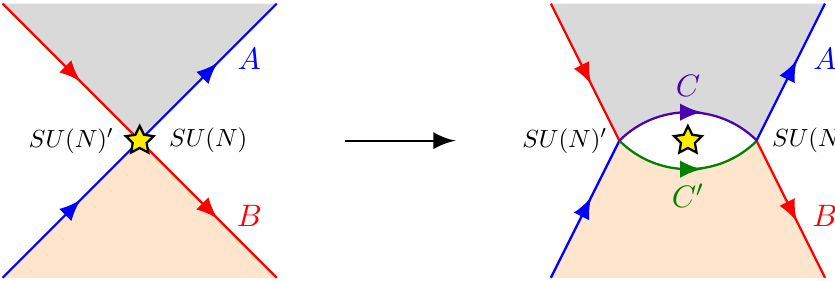
Figure 7. Antisymmetric tensor deconfinement as seen from the brane tiling point of view. On the left hand side we have two NS5 branes, A and B , intersecting on top of an orientifold plane (the star), giving rise to an antisymmetric representation of the SU( N ) flavour symmetry group, which here comes from the white wedge on the left/right (we denote by SU( N ) 0 its orientifold image). The deconfined description [27–29] arises from recombining the NS5 branes in a way that avoids the orientifold plane. 5-brane charge conservation requires the appearance of a D5 wrapping the disk bounded by the two new NS5 branes C and C 0 , leading to an extra (confining) USp factor. [Figure reproduced from [18] with